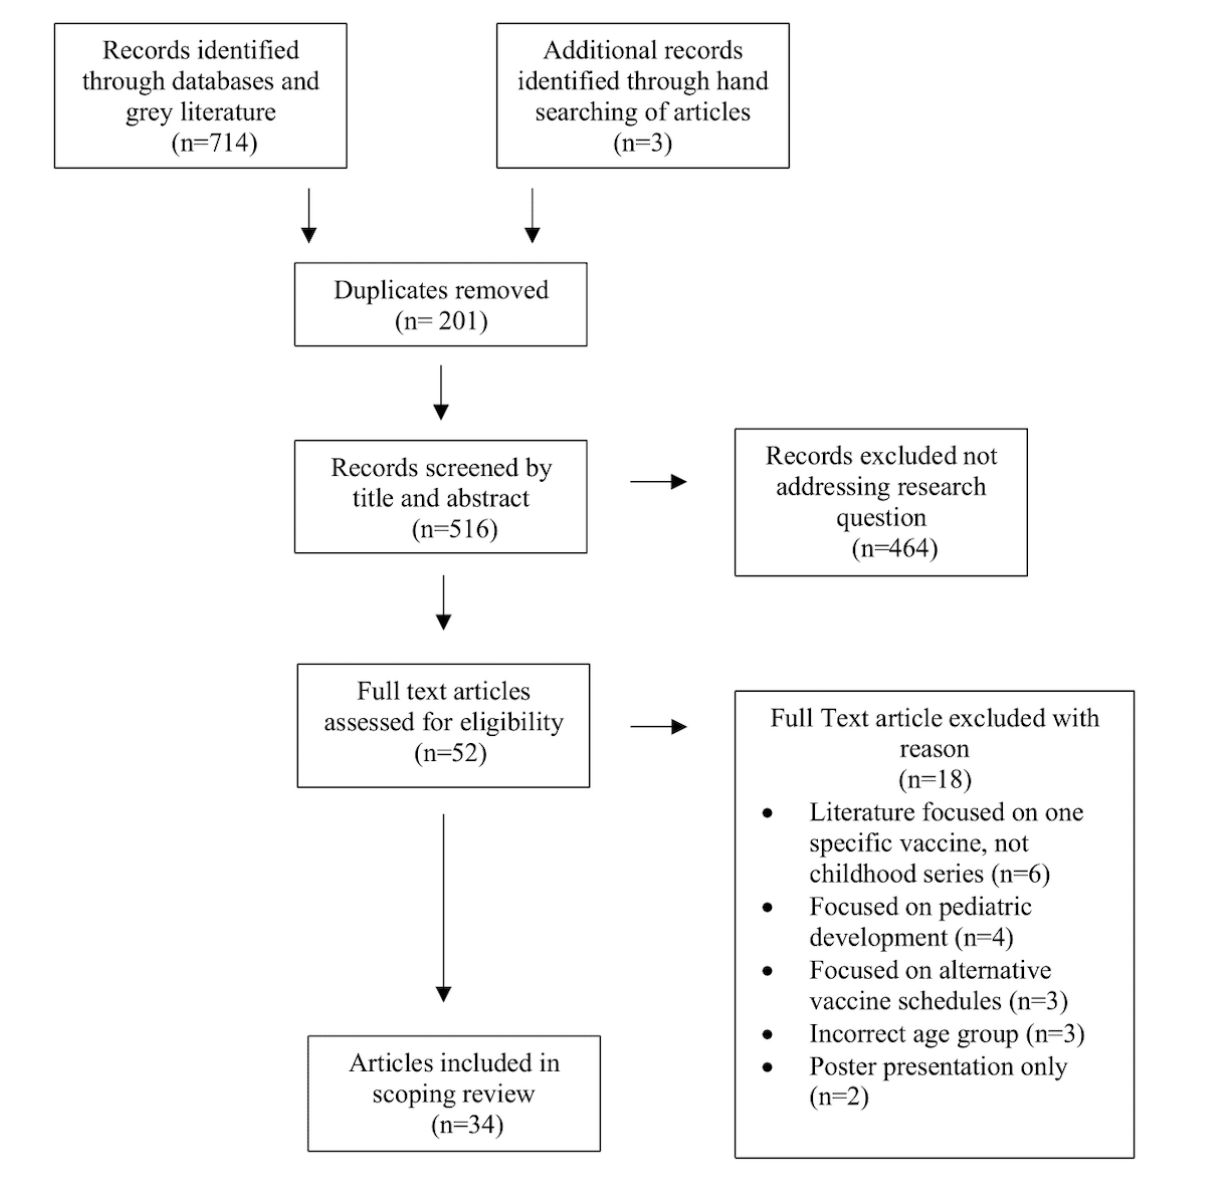
Figure 1. PRISMA process to select